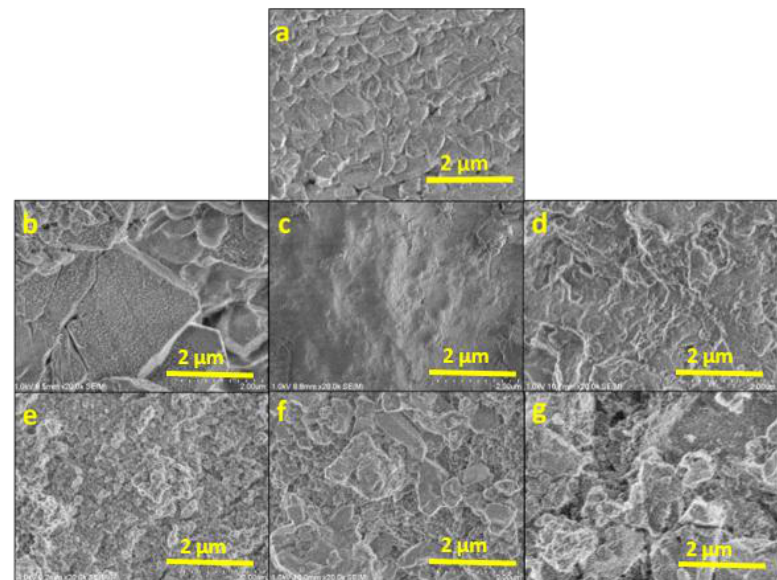
Coatings 2017 , 7 , x FOR PEER REVIEW 10 of 14